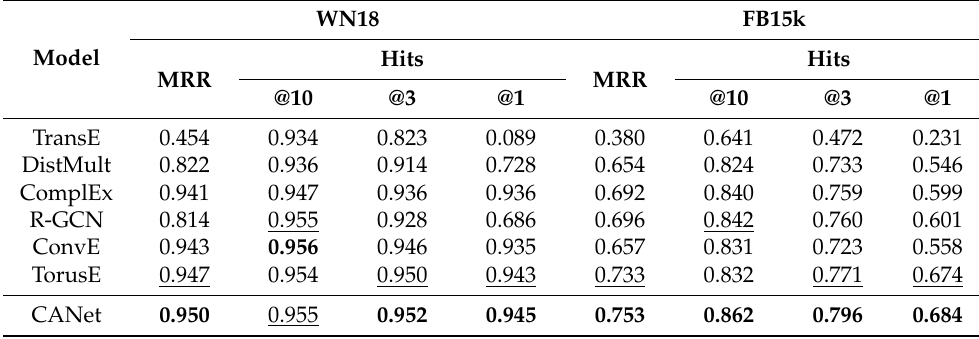
Table 3. The MRR and Hits@k of the link prediction results on the WN18RR and FB15k-237 datasets.